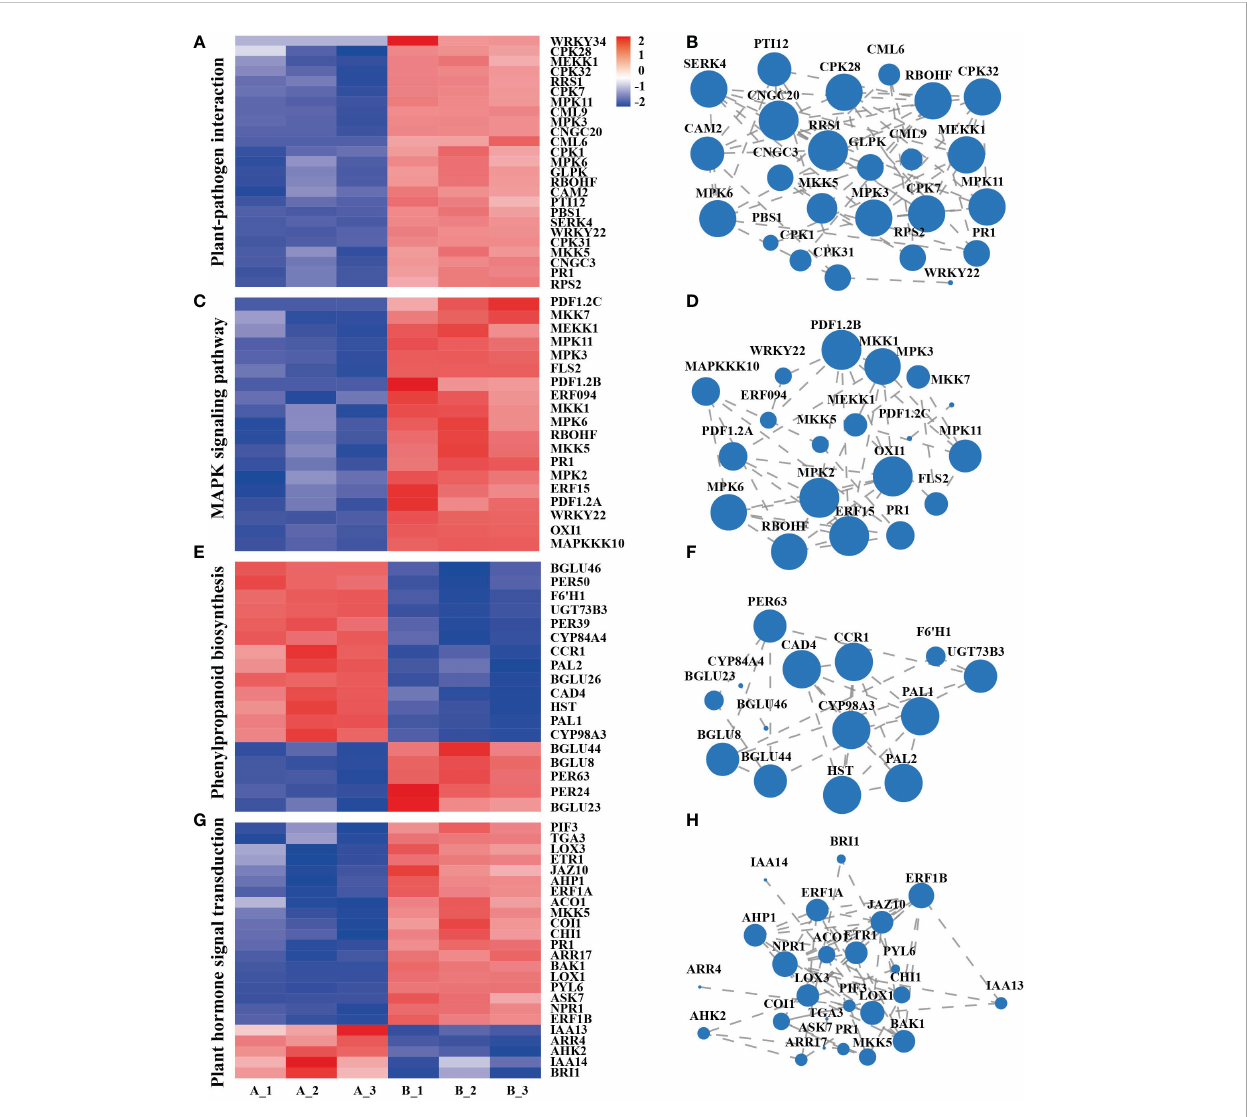
FIGURE 4 Integration analysis of genes of the major signaling pathways of the transcriptome KEGG Pathway. (A, B) Gene enrichment and expression correlation analysis of genes involved in the plant-pathogen interaction pathway. (C, D) Correlation analysis of the enrichment and expression of genes involved in the MAPK signaling pathway. (E, F) Gene enrichment and expression correlation analysis of the biosynthetic pathway gene of phenylpropanoid biosynthesis. (G, H) Gene enrichment and expression correlation analysis of plant hormone signal transduction pathways. Each node represents a gene, and the line between nodes represents the correlation of expression between genes. The larger the node, the greater the number of expression correlations between the gene and other genes. Heatmap shows FPKM values in each treatment, normalized using